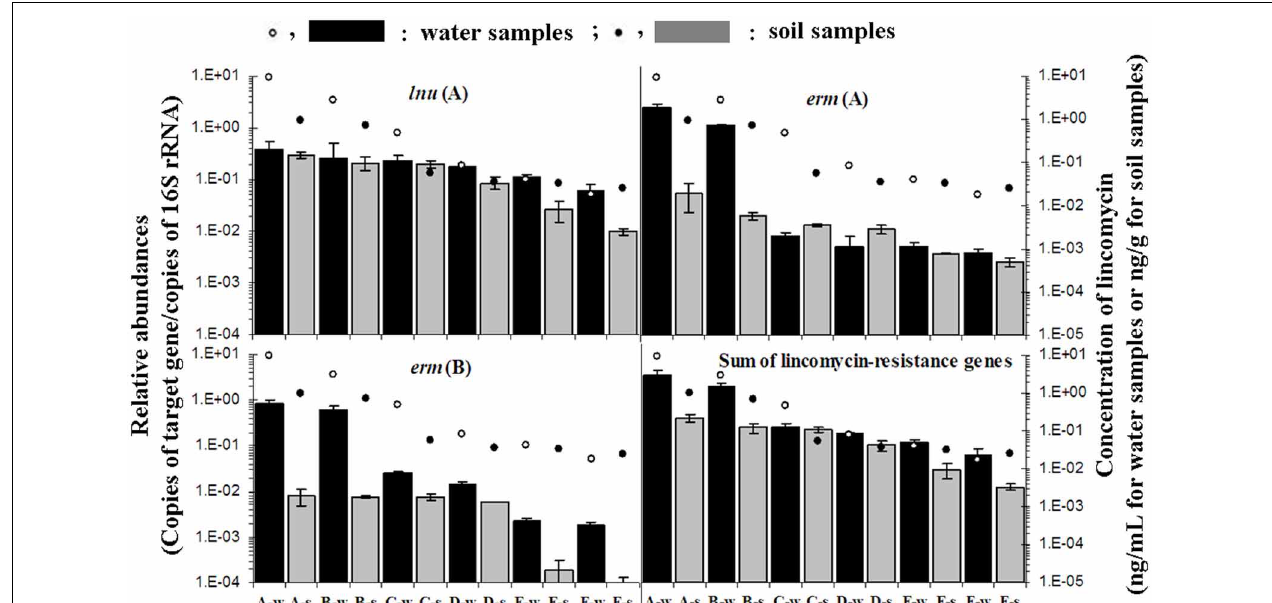
FIGURE 2 | Relative abundance of lincomycin-resistance genes: lnu (F), erm (A), erm (B), and the sum of the nine lincomycin resistance genes [ lnu (F), erm (A), erm (B), lnu (A), lnu (D), vga (C), vga (E), vga (A), and vga (D)] and concentration of lincomycin. Black bars and blank symbols indicate a relative abundance of